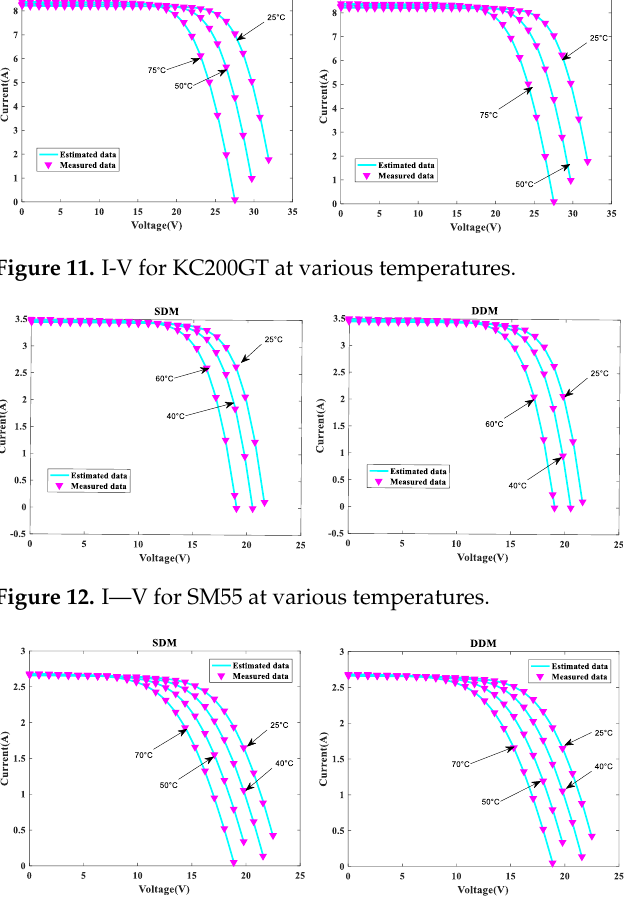
Figure 13. I-V for ST40 at various